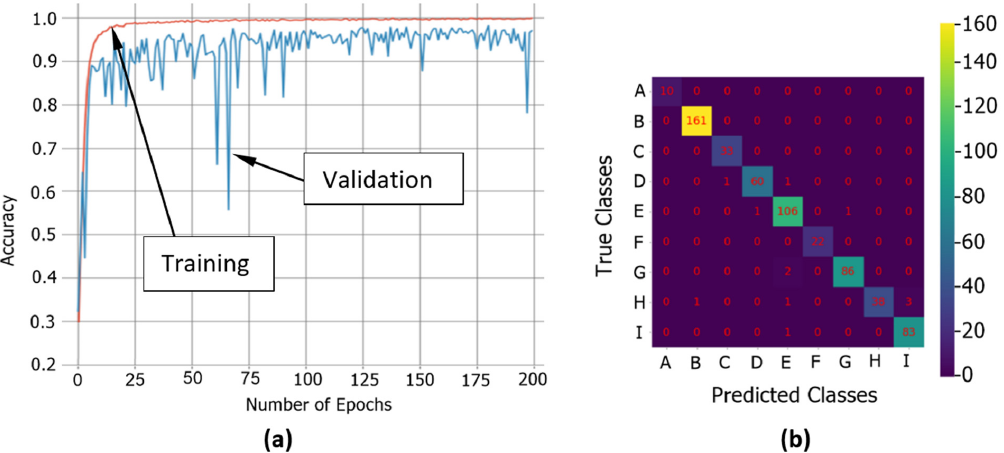
Figure 12. ( a ) Accuracy function for Training and Validation datasets for InceptionV3 model during the second pass, 200 epochs. ( b ) Confusion matrix for the test set. Apple variety legend: (A) Blanquina, (B) Carrió, (C) Florina, (D) Fuentes, (E) Prieta, (F) Raxao, (G) Reineta Encarnada, (H) Reineta Pinta, (I) Reineta Roja del Canadá.